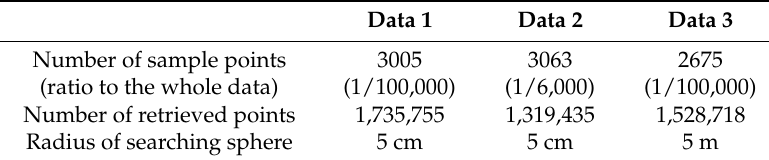
Table 7. Performance comparison among octree implementing methods using Data 1.